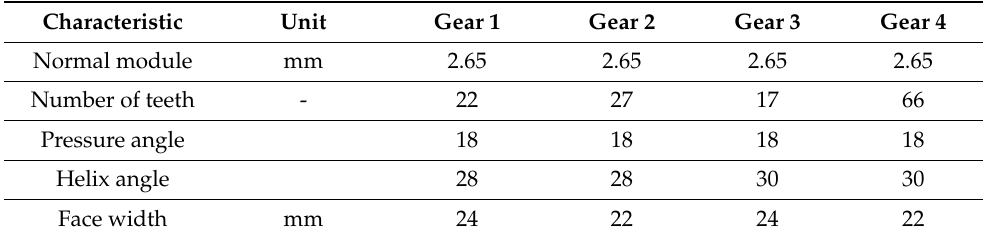
Table 1. Gears’ geometrical characteristics.